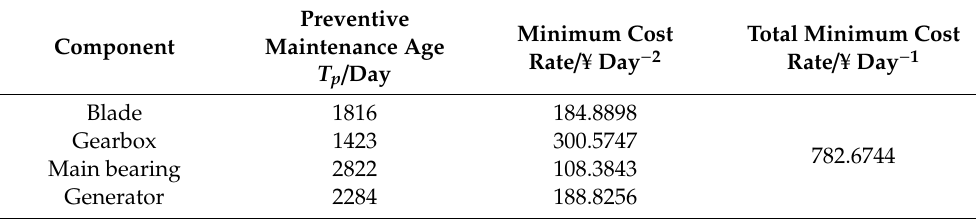
Table 10. Optimization results of age maintenance